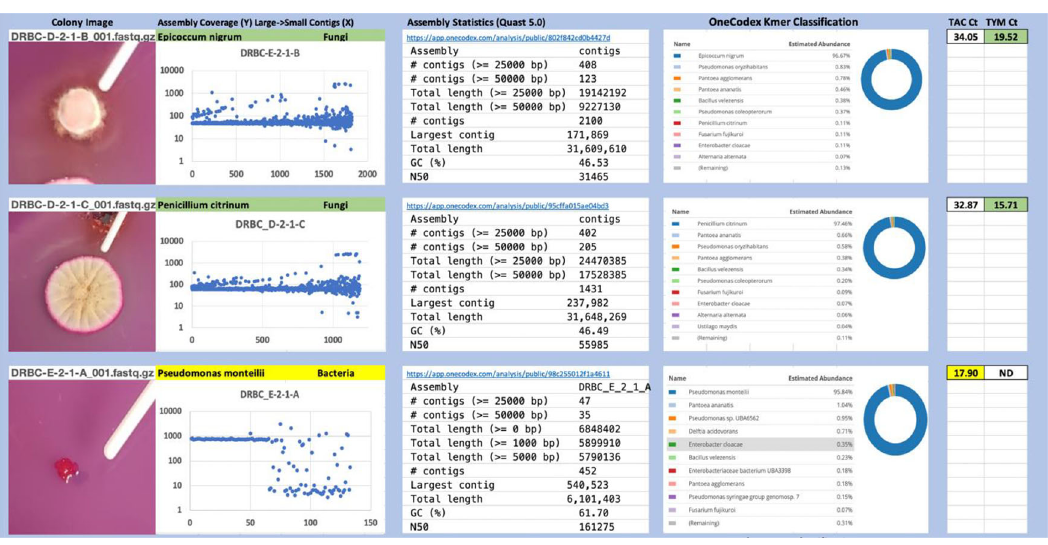
Figure1.DRBCwithchloramphenicol. ColonyImage(Left),Assemblysequencecoverage(Y)comparedwithcontig Length (X)where the contigs aresorted largest tosmallest from left toright (Mid-Left). Assembly statistics calculated with Quast 5.0 (Mid Right). OneCodex speciated Kmer count